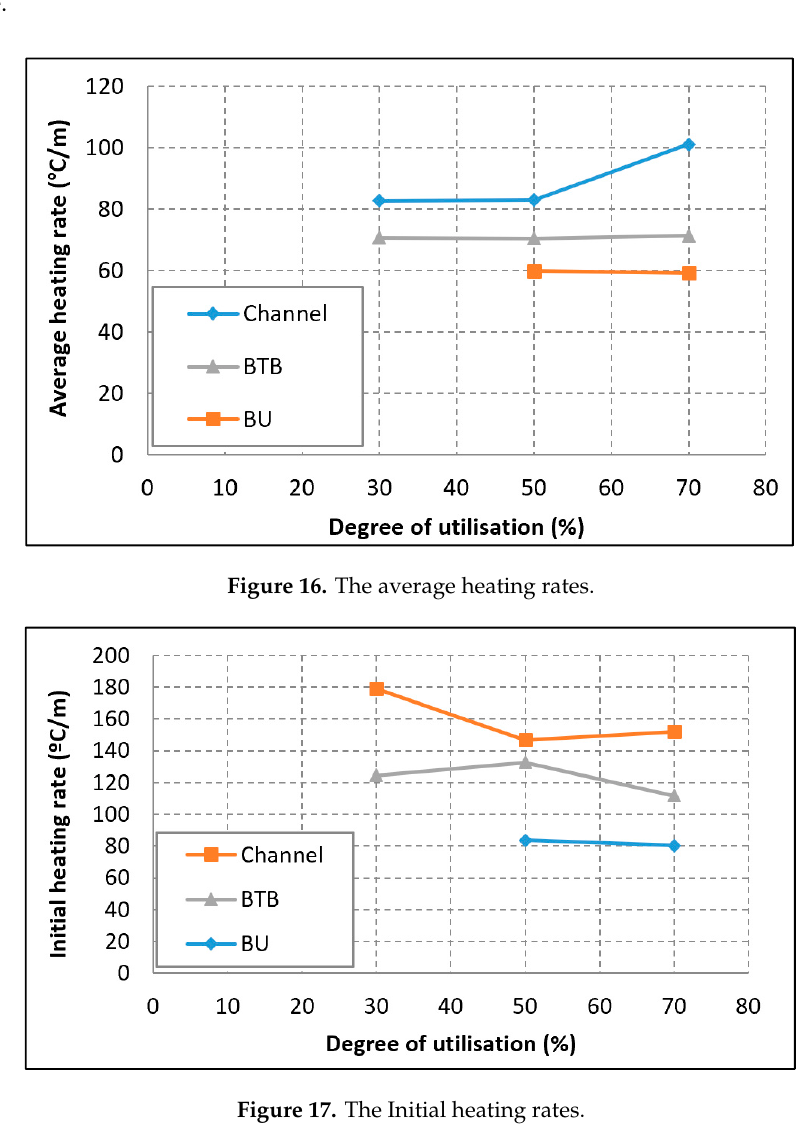
Figure 17. The Initial heating rates.